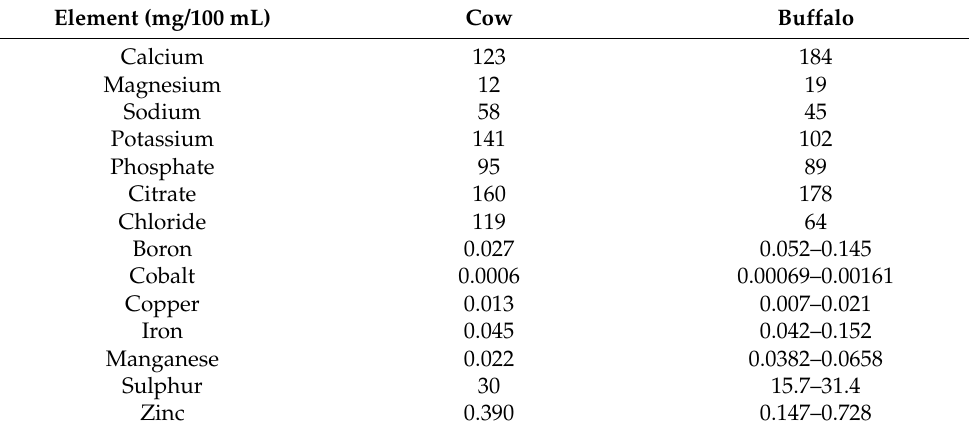
Table 8. Levels of minerals and trace elements in buffalo and cow